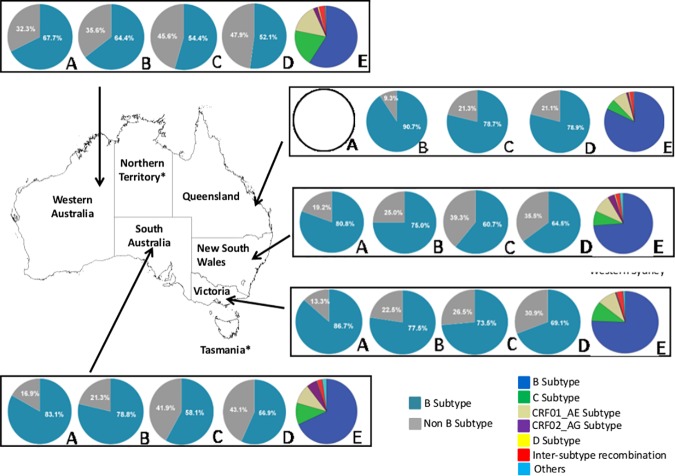
Australian HIV-1 subtype distribution for 4,873 sequences for B subtype (aqua) and non-B subtypes (grey) over time [2005–2006 (A), 2007–2008 (B), 2009–2010 (C) and 2011–2012 (D)] including the distribution and proportion of HIV-1 subtypes represented in each Australian state (E) from 2005–2012 (blue = B subtype; green = C subtype; tan = CRF01_AE subtype; maroon = CRF02_AG; yellow = D subtype; red = inter-subtype recombination (ISR); light blue = others).